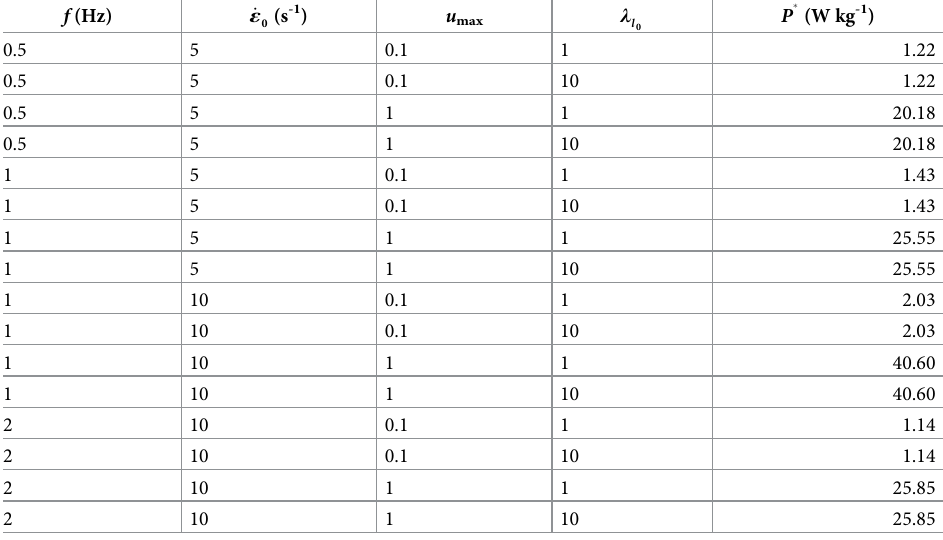
Table 3. Output mass-specific mechanical power output P (cid:3) for all